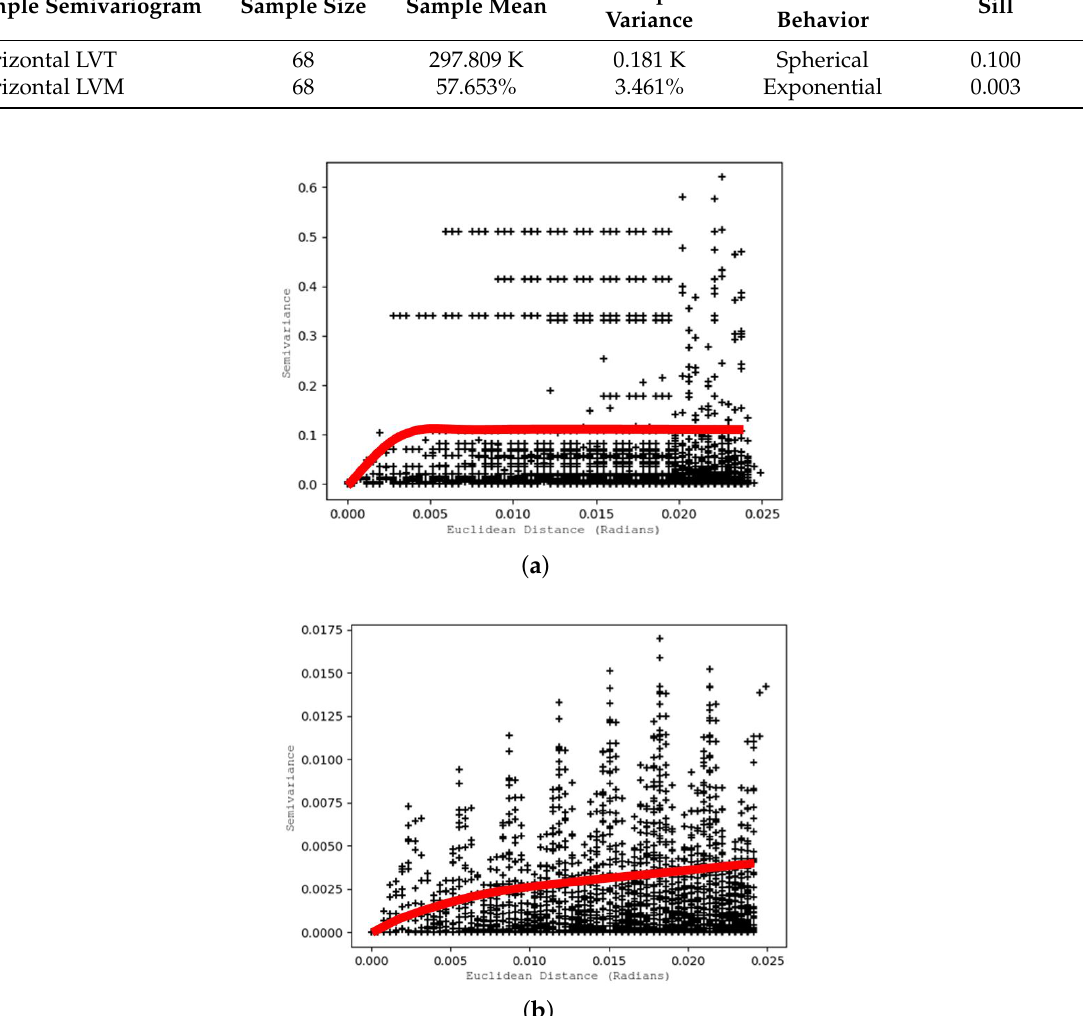
Figure 8. Horizontal sample semivariogram of LVT ( a ) and LVM ( b ) at pressure level